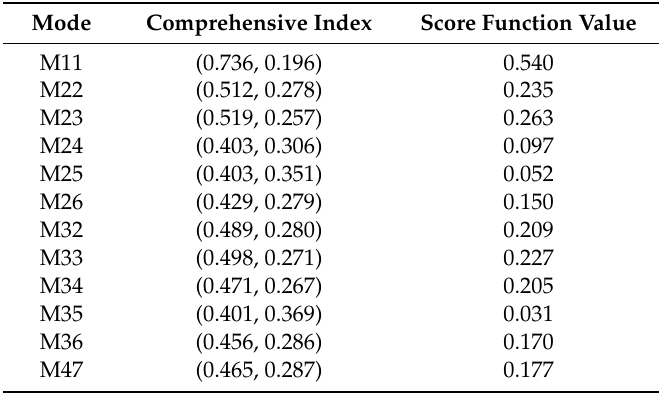
Table 10. Comprehensive index value of various alternative